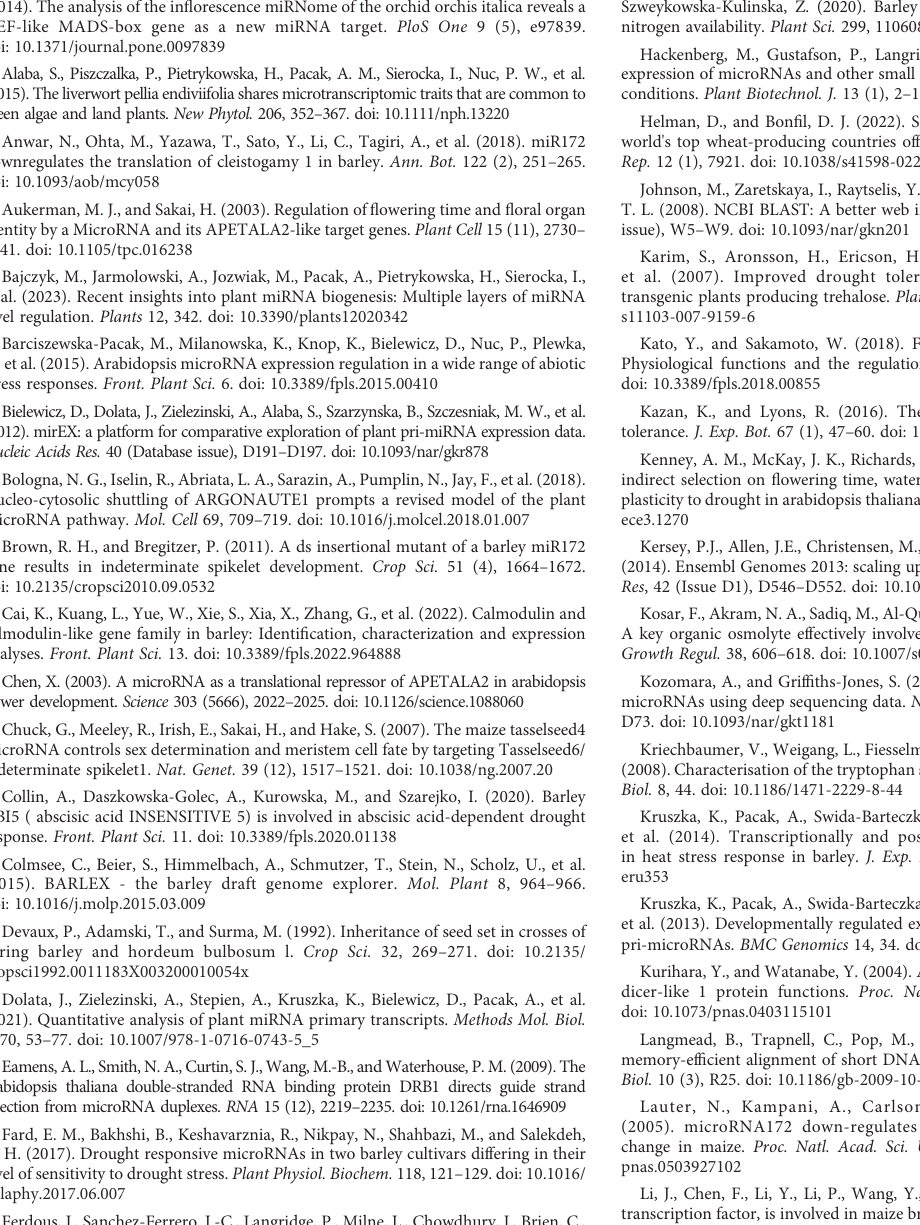
Figueroa, C. M., and Lunn, J. E. (2016). A tale of two sugars: Trehalose 6-phosphate and sucrose. Plant Physiol. 172 (1), 7 – 27. doi: